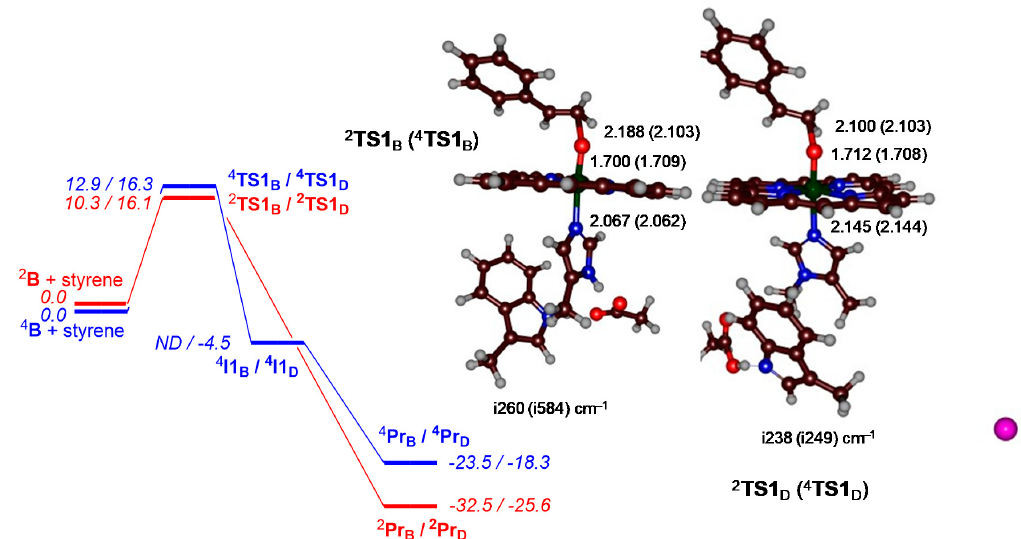
Figure 4. Potential energy landscape of styrene epoxidation by 2,4 B and 2,4 D as calculated at UB3LYP/BS1 in Gaussian-09. Energies (UB3LYP/BS1//UB3LYP/BS2+ZPE+E solv ) are in kcal mol − 1 with respect to isolated reactants and give values for the reaction of B / D and doublet spin results in red and quartet spin results in blue. Optimized geometries of the rate-determining transition states give bond lengths in angstroms and the imaginary frequency in cm − 1 .